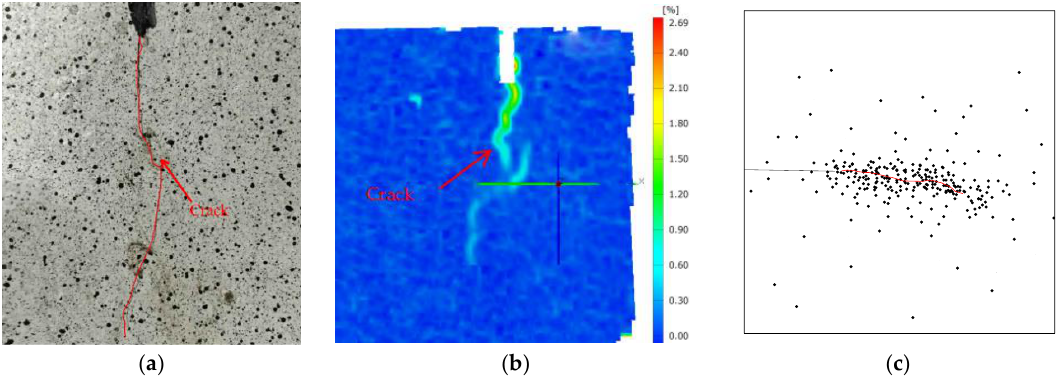
Figure 9. Crack propagation. ( a ) Crack propagation on specimen surface; ( b ) generalized strain distribution on specimen surface; ( c ) AE events location on specimen surface.